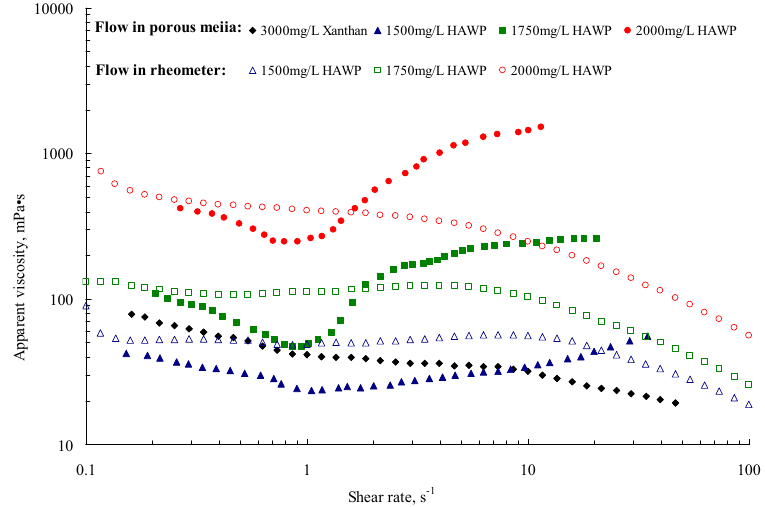
Figure 3. Apparent viscosity vs. shear rate for different polymer solutions.